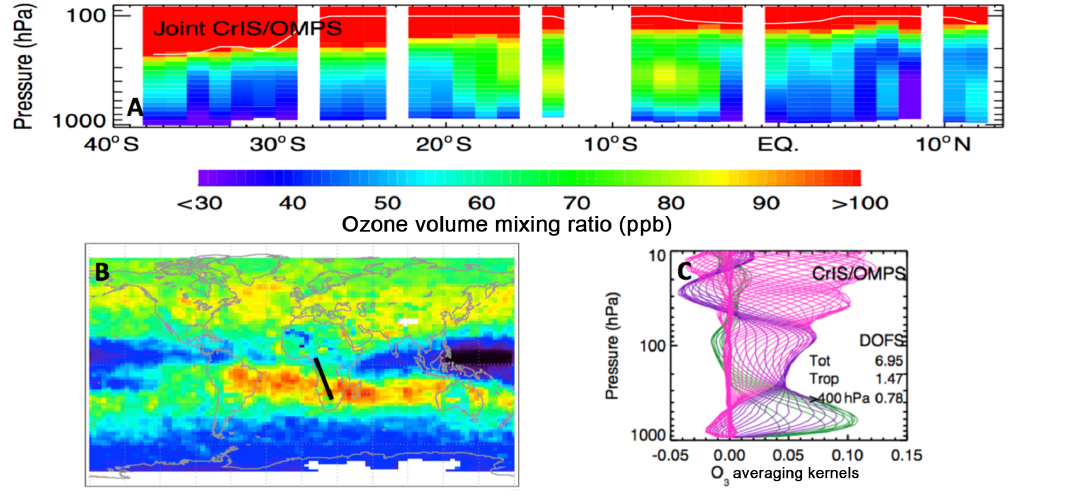
Figure 7. Joint CrIS + OMPS ozone profile retrievals over Africa on 21 October 2013. The elevated ozone concentrations between 2 and 20 ◦ S are associated with biomass burning. (A) The retrieved ozone concentration profiles along the transect measurements. The white curve indicates the tropopause pressure reported by GEOS-5. (B) TES monthly mean ozone concentration at 510hPa. The black line indicates the joint CrIS + OMPS measurement location. (C) The averaging kernels of joint CrIS + OMPS